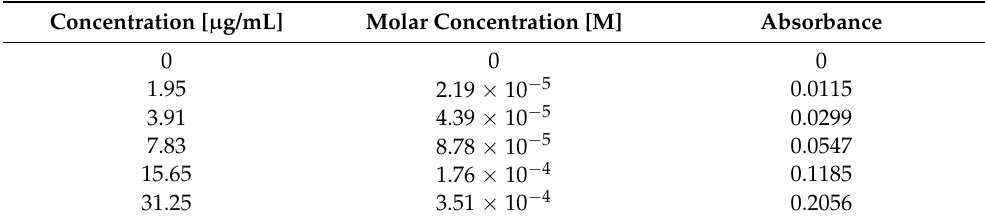
Table 3. Beta alanine concentrations used to build the experimental calibration curve. Concentration [ µ